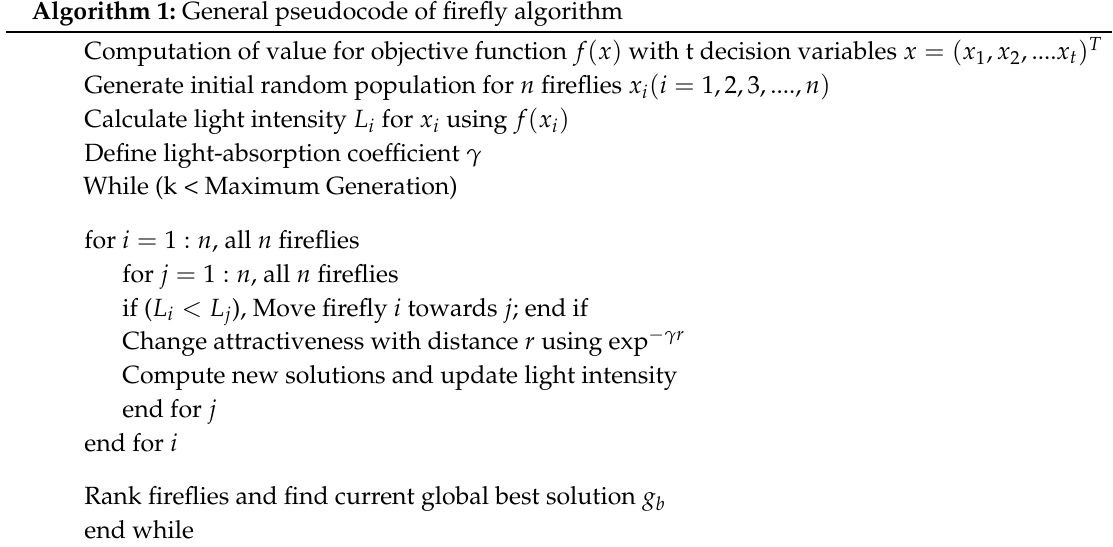
Algorithm 1: General pseudocode of firefly